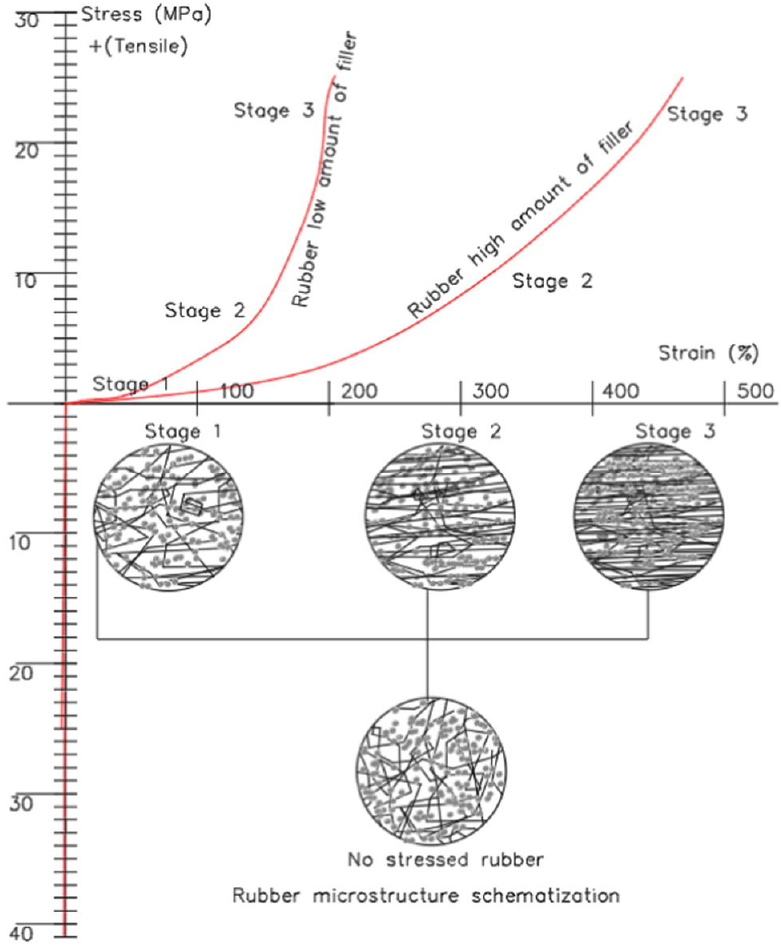
Figure 1. Schematic representation of stress–strain and microstructural behaviours of two thermoset rubbers.